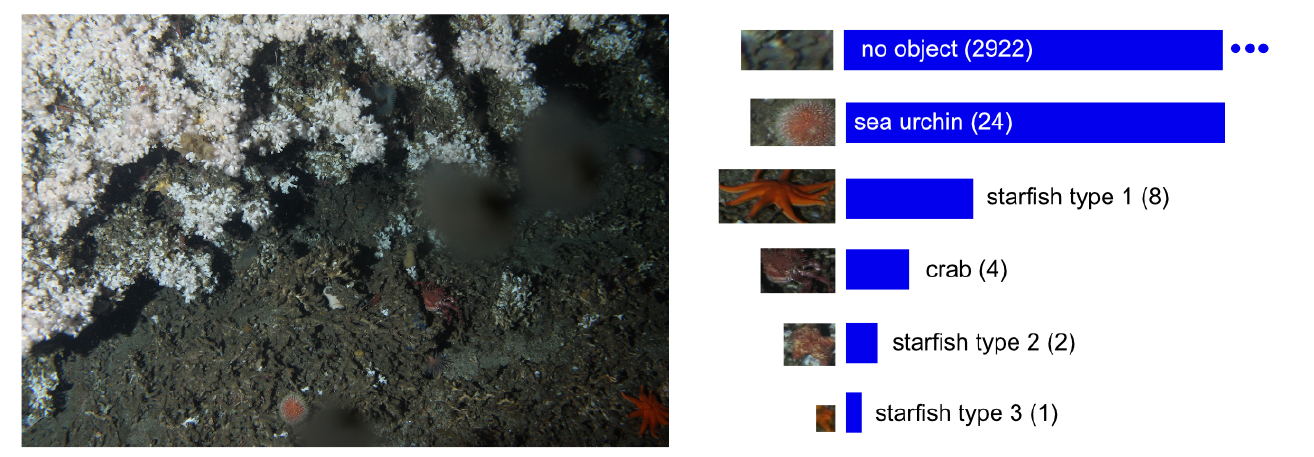
Figure 2. Images from the LoVe observatory. Left : An original image. Right : The LoVe data set (LV) as used in the experiments in Section 4.2. The numbers in brackets indicate the number of samples in a class. The three dots indicate that the bar for the images containing no object is out of scale for better